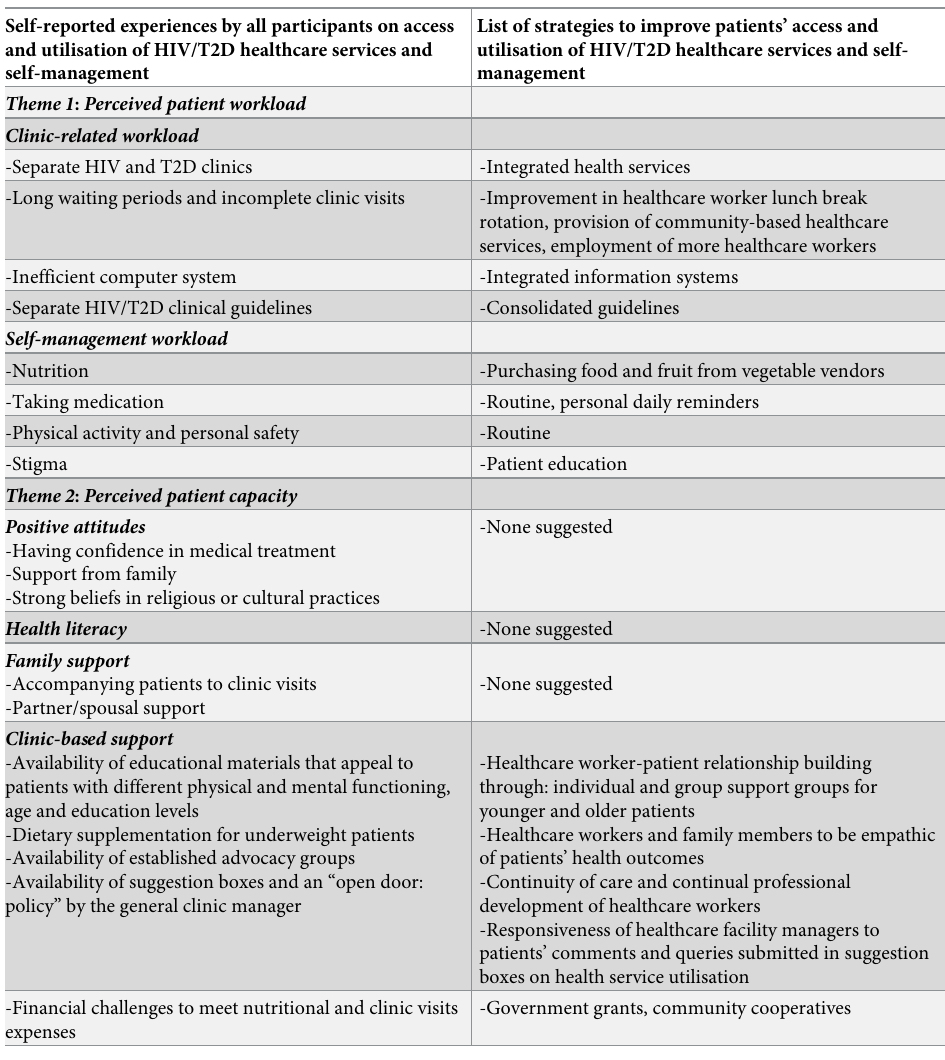
Table 2. Summary of interview